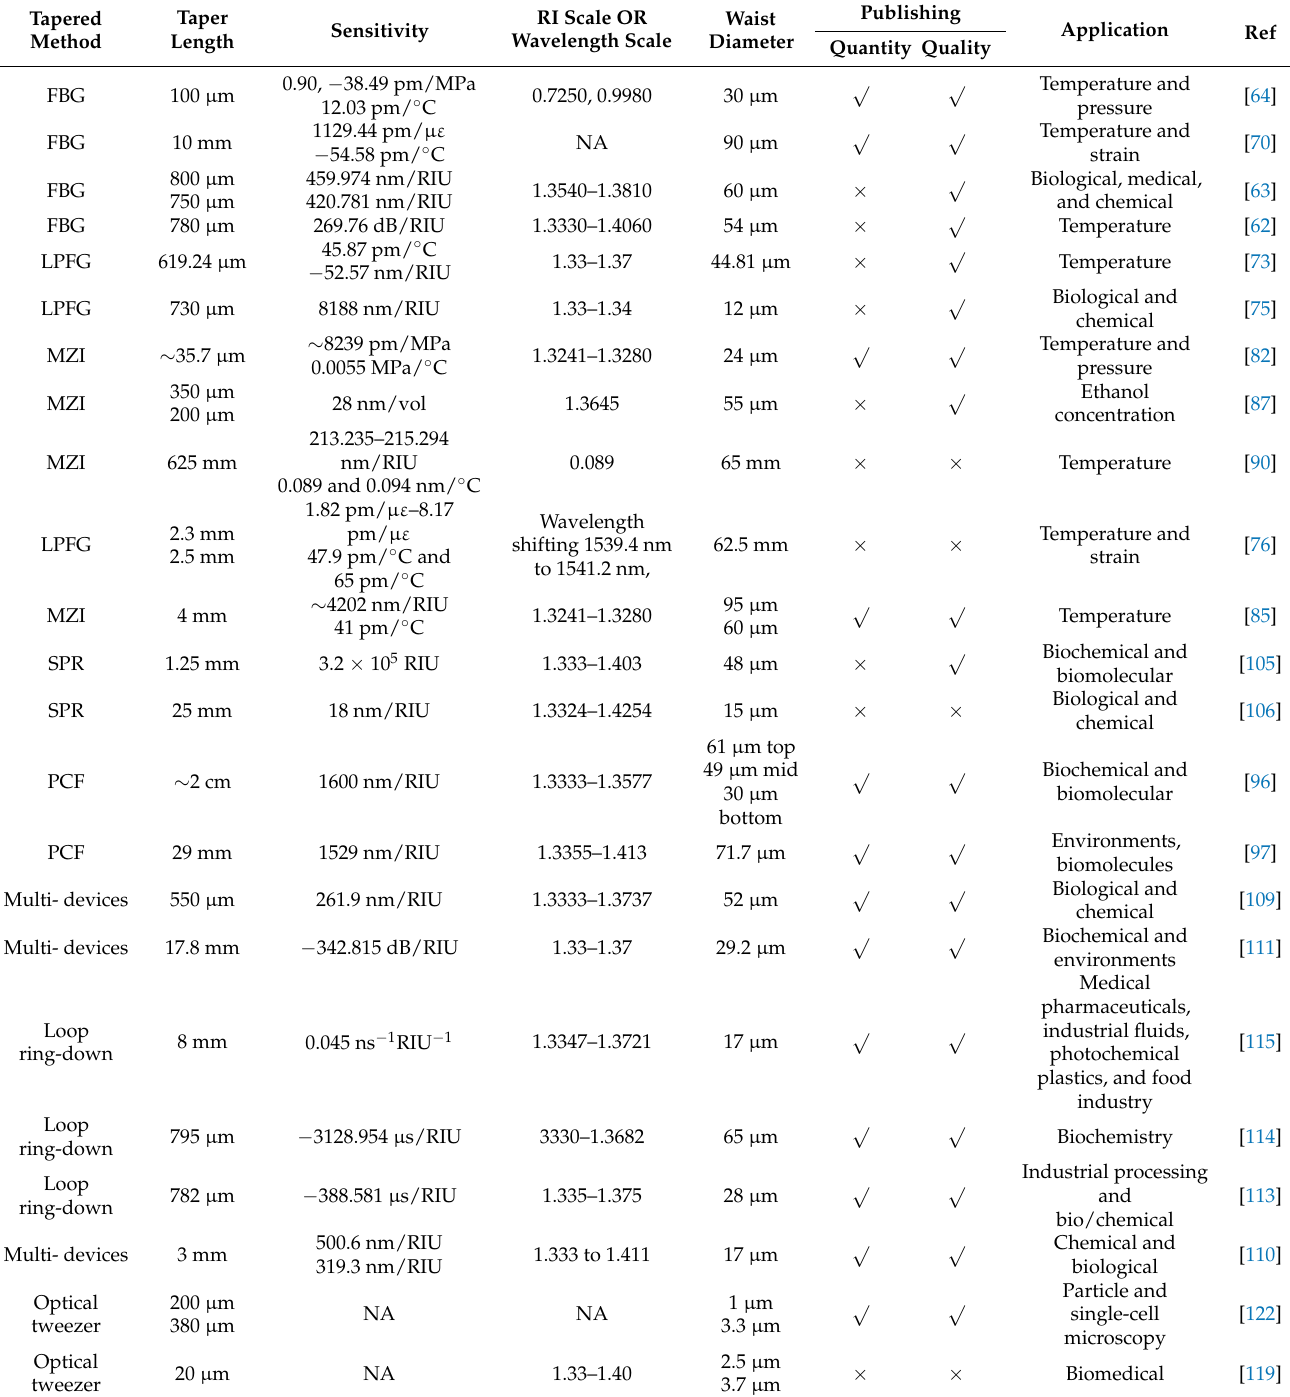
Table 1. Studies analysis for categorizes tapered-fiber